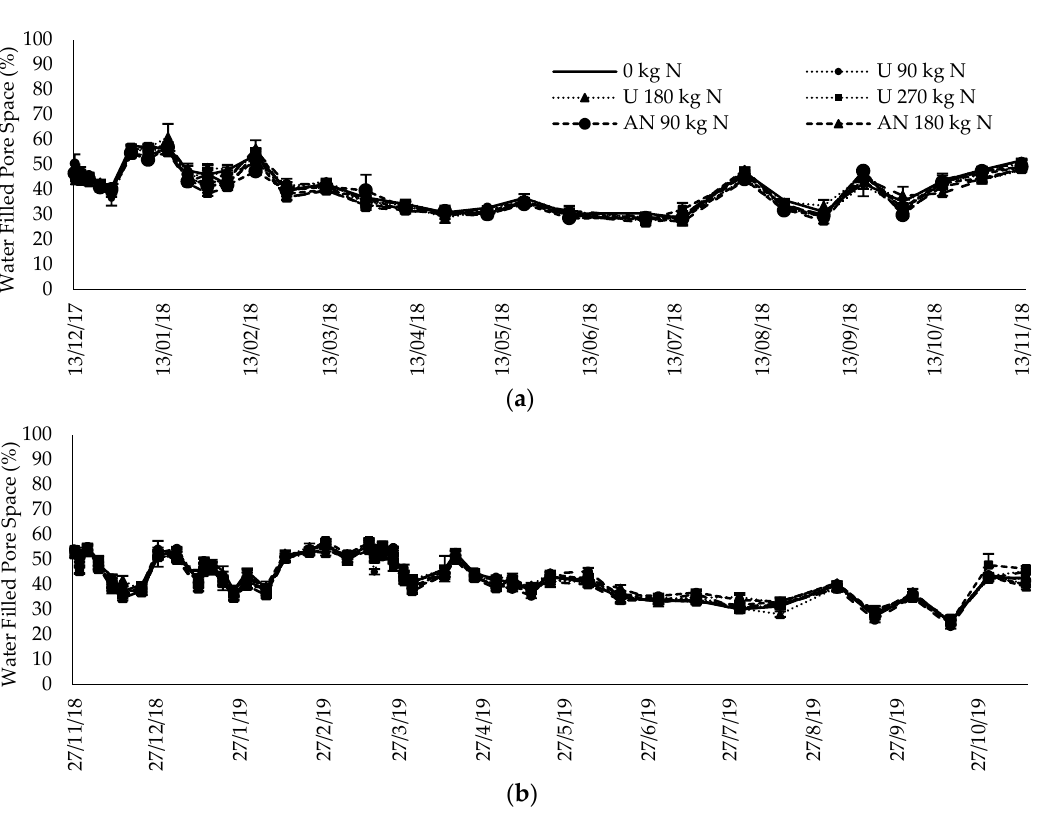
Figure 1. Daily ambient temperature (minimum, mean, and maximum; T; °C) and daily precipitation (P; mm). Data were obtained from the Agrometeorological Station, Department of Exact Sciences, FCAV/UNESP, located 1.5 km from the experiment site. Experiment 1 ( a ) and 2 ( b ).